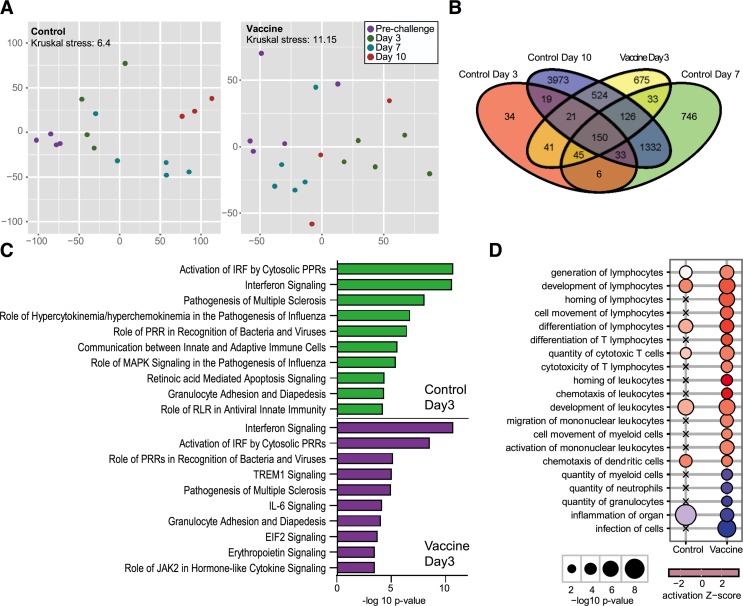
Distinct transcriptional responses following viral challenge in control and vaccinated macaques.A) Expression profiles of the union of 3973 genes found to be differentially expressed were visualized using multidimensional scaling (MDS). The MDS shows similarities between individual profiles. Differential expression cutoff was set to |Fold Change| >1.5 and a q-value < 0.05 calculated using a moderated t-test with Benjamini-Hochberg correction. Each datapoint represents an individual in either the control (left, n = 8) or vaccinated (right, n = 8) group. Distinct color denotes the timepoint at which BAL samples were collected. The Kruskal stress value denotes the quality of the 2D representation of differential gene expression between groups as a fraction of the information lost during the dimensionality reduction procedure. (B) Overlap of DE transcripts in vaccinated and control macaques across time. C) Top 10 canonical pathways found to be significantly enriched at day 3 post challenge in vaccinated and control macaques. Bar graphs represent enrichment scores as determined by the–log10 p-value as calculated by right-tailed Fisher’s exact test. D) Biological functions associated with differentially expressed genes uniquely in vaccinated macaques at day 3 post challenge. Significantly enriched biological functions were those in which |activation z-scores < 2|. Activation z-scores are denoted in by the color of the bubbles. Red indicates upregulation and blue indicates inhibition of biological functions. Bubble diameter represents the–log10 p-value. Crosses signify no observable enrichment of a biological function.